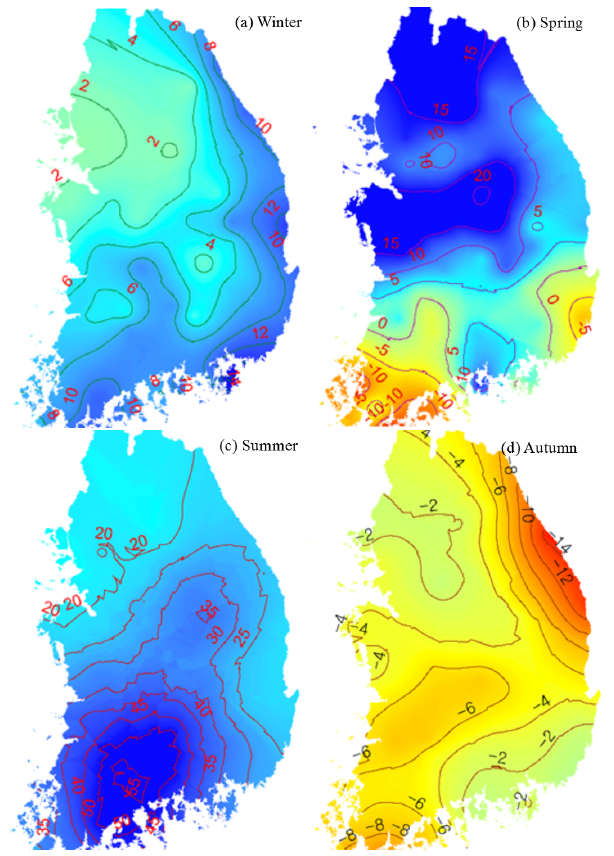
Figure 11. Spatial distribution of mean difference of seasonal pre- cipitation (mm) with 0.5 ◦ C increasing mean temperature in South Korea. Note that the scale of summer is different from the other seasons and the 95% significance intervals are different at each sta- tion and the mean values of the significance intervals are ± 5.38, ± 15.04, ± 29.94, and ± 4.84 for Winter (December, January,